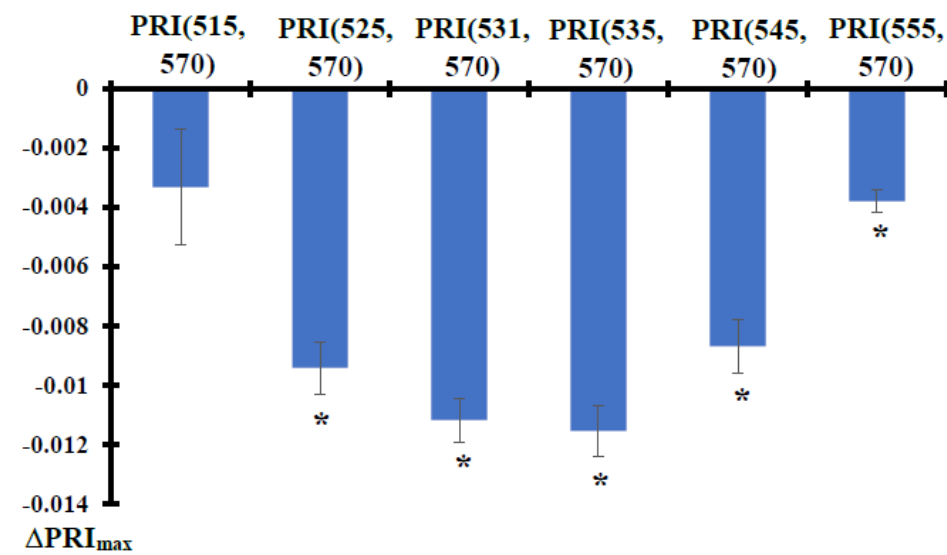
Figure 4. Averaged maximal magnitudes of ∆ PRI(515,570), ∆ PRI(525,570), ∆ PRI(531,570), ∆ PRI(535,570), ∆ PRI(545,570), and ∆ PRI(555,570) in pea leaves under actinic light with an intensity equal to 1599 µmol m -2 s -1 ( n = 6). The magnitudes were measured before termination of the illumination by actinic light. * indicates that the ∆ PRI was significant ( p < 0.05).